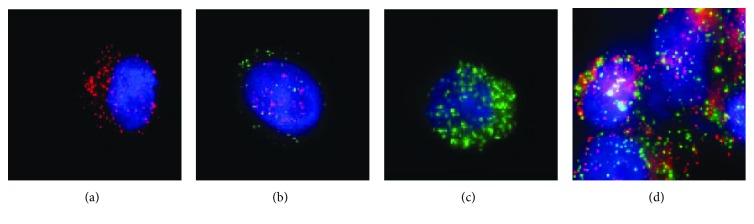
Detection of CTCs and CTMs in the peripheral blood of patients with colorectal cancer. (a) EpCAM expression (red fluorescence) in epithelial CTCs (E-CTCs). (b) EpCAM and vimentin expression (red and green fluorescence, resp.) in epithelial/mesenchymal CTCs (E/M-CTCs). (c) Vimentin expression (green fluorescence) in mesenchymal CTCs (M-CTCs). (d) CTMs, consisting of E/M-CTCs. Magnification, ×100. CTC, circulating tumor cell; CTMs, circulating tumor microemboli; EpCAM, epithelial cell adhesion molecule.